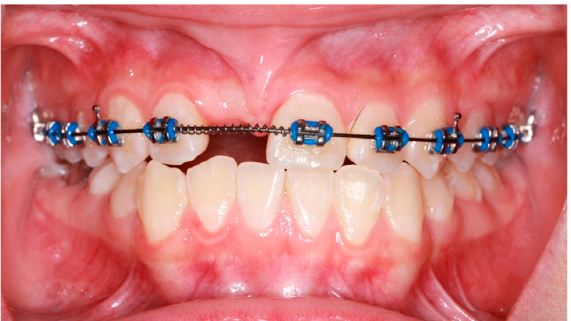
Figure 6. Pre-surgical intraoral